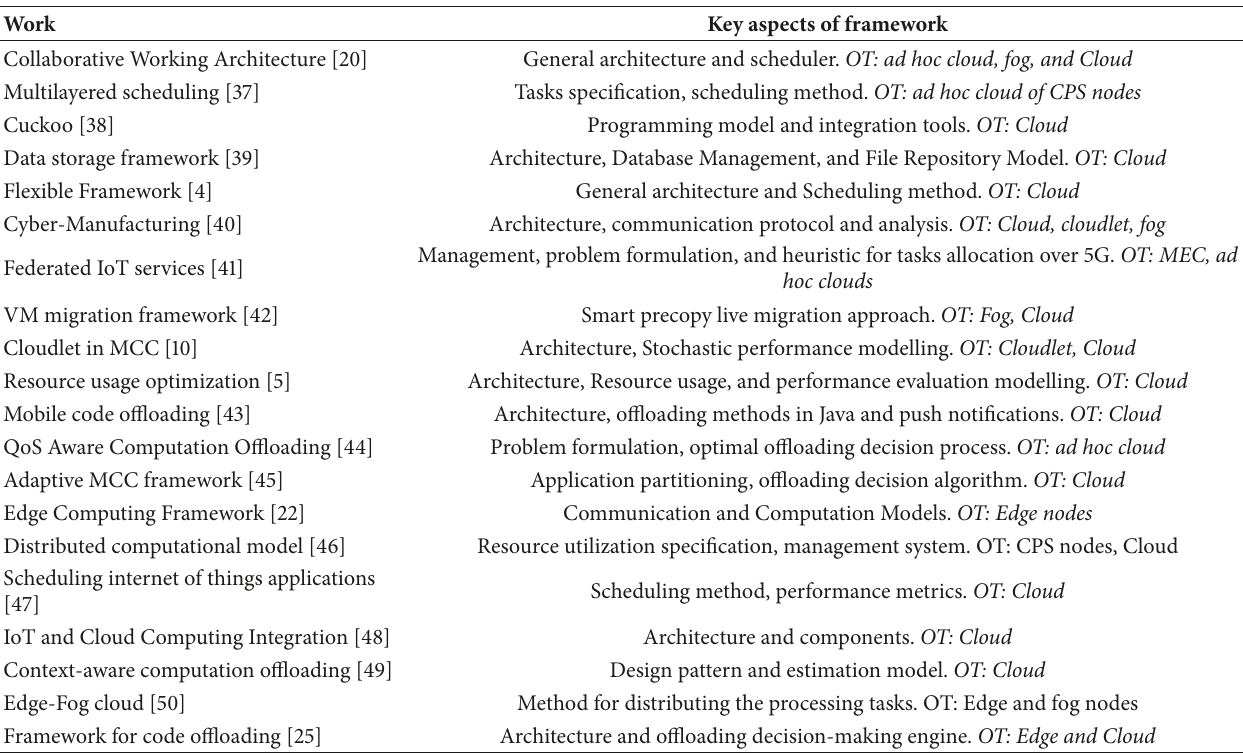
Table 1: Recent frameworks for MCC. Key aspects of